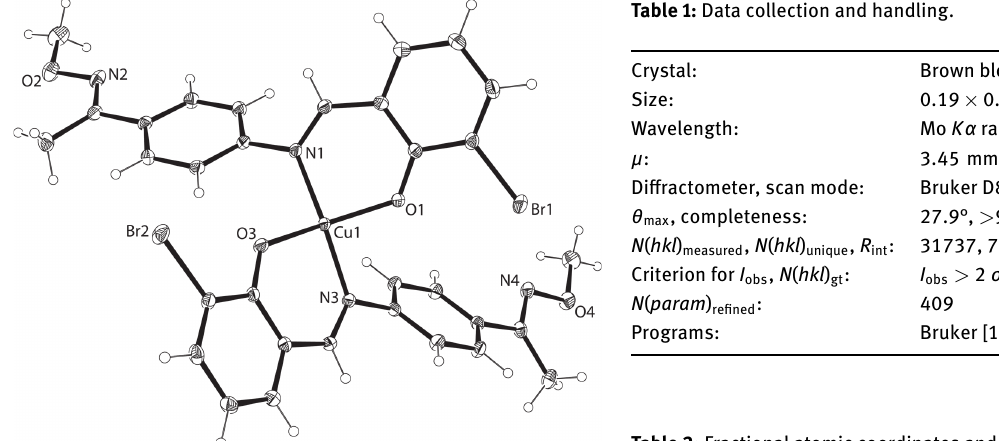
Table 2: Fractional atomic coordinates and isotropic or equivalent isotropic displacement parameters (Å 2